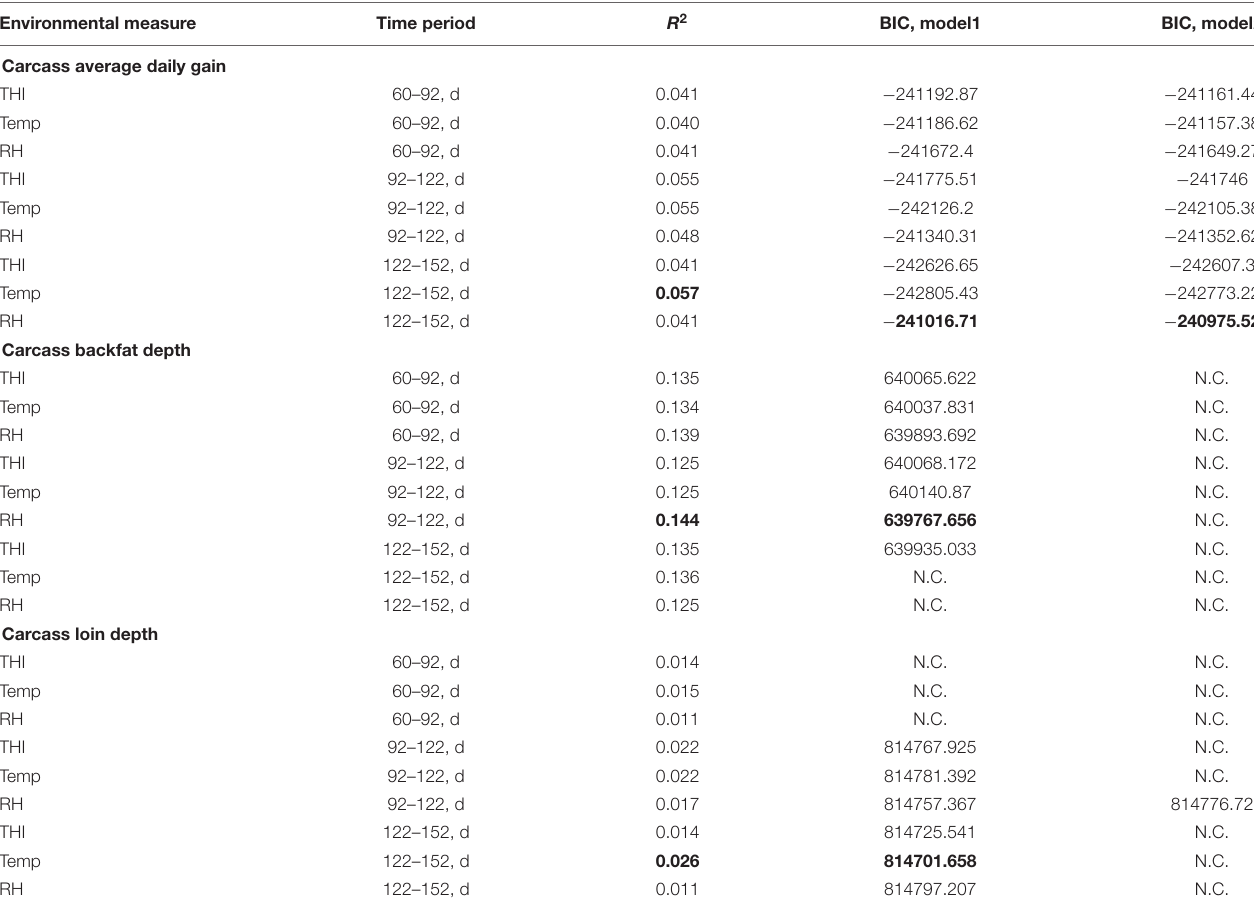
TABLE 2 | Coefficients of determination and Bayesian information criterion values for the models assessing the impact of different heat load functions on the traits of interest. Environmental measure Time period R 2 BIC, model1 BIC,